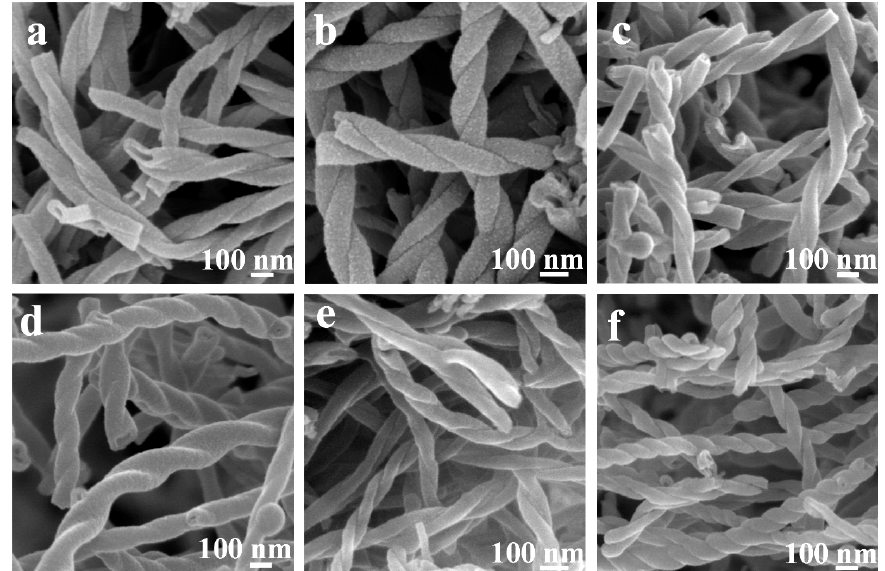
Figure 4. FESEM images of ( a , b ) 4,4 ′ -biphenylene bridged polybissilsesquioxane nanotubes; ( c , d ) carbon/silica nanotubes; and ( e , f ) carbonaceous nanotubes. The samples were prepared using ( a , c , e ) LL-8 and ( b , d , f ) DD-8 . Reproduced with permission from [47]. Copyright 2013 WILEY-VCH Verlag GmbH & Co. KGaA.